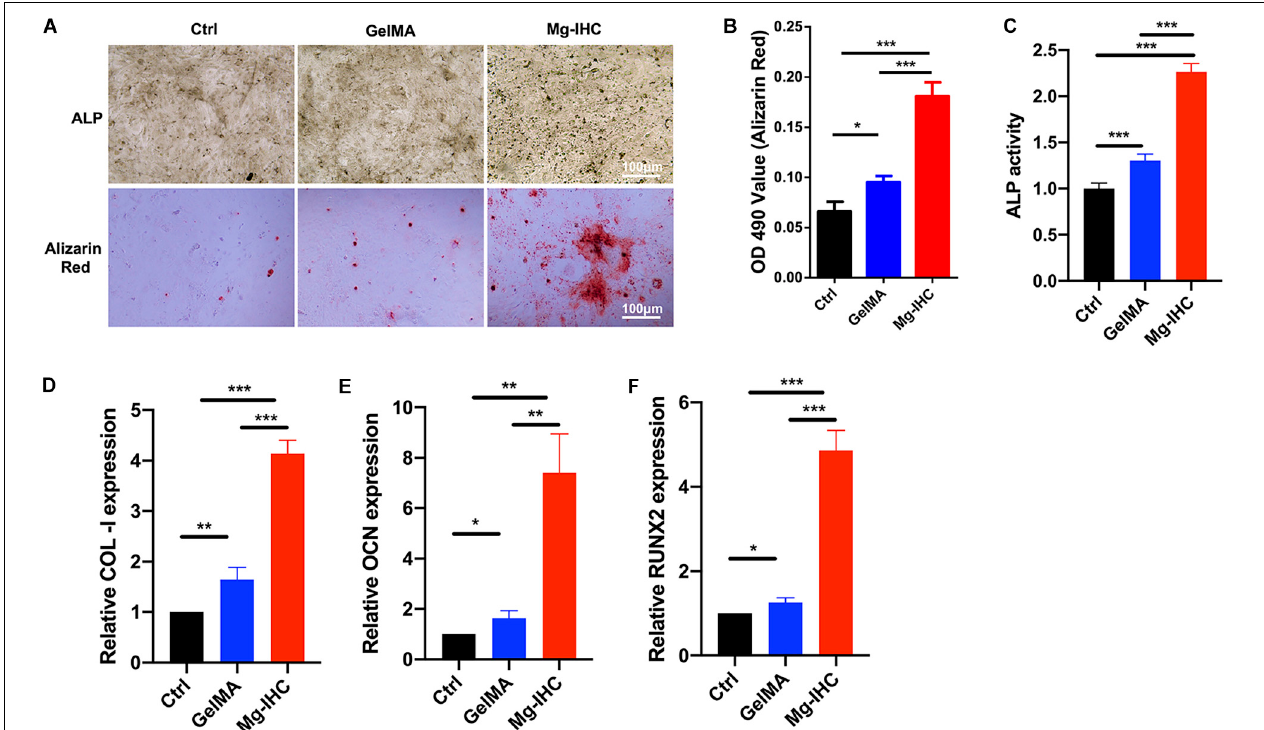
FIGURE 3 | The effect of Mg-IHC on osteogenesis was examined in vitro . (A) MC3T3-E1 cells were cultured with GelMA and Mg-IHC extracts, and ALP was stained with ALP staining kit 7 days after osteogenesis induction, and calcium nodules were stained with alizarin red 14 days later. (B) Quantitative results of alizarin red staining. (C) MC3T3-E1 cells were cultured with GelMA and Mg-IHC extracts, and ALP activity was quantitatively detected using ALP activity kit 7 days after osteogenesis induction. (D–F) MC3T3-E1 cells were cultured with GelMA and Mg-IHC extracts, and 14 days after osteogenesis induction, the expression of osteogenesis-related genes COL-I, OCN, and RUNX2 was detected by real-time PCR. * P < 0.05; ** P < 0.01; *** P <